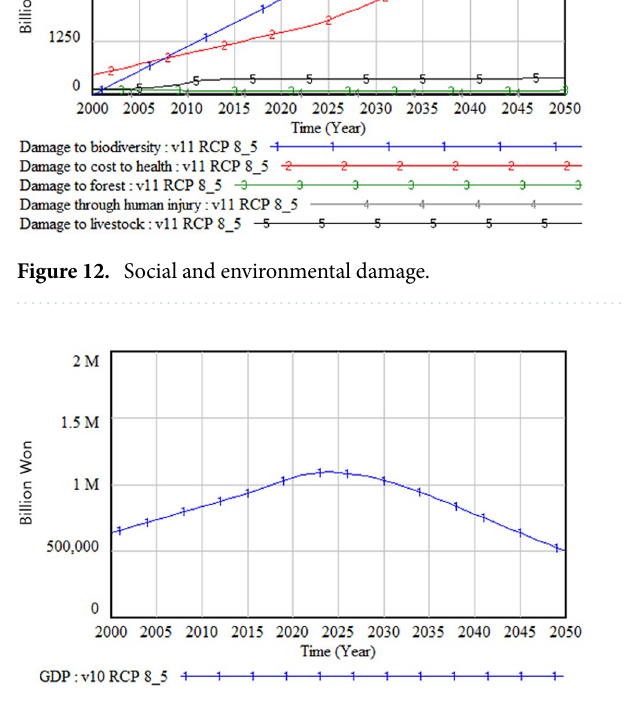
Figure 13. Gross domestic product (GDP) change.